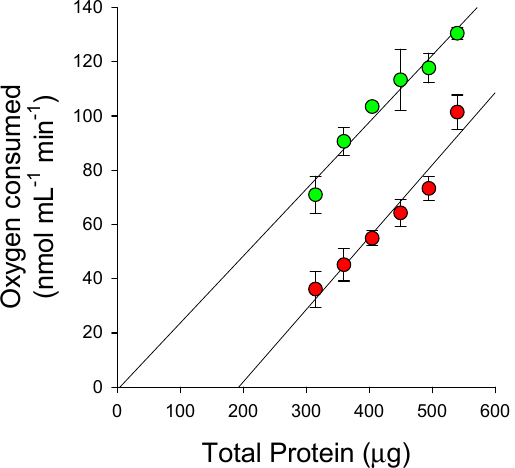
Figure 2. Titration of HPPD activity in TSP extract as measured by oxygen consumption in the presence of 0 ( • ) and 3.75 µ M of 4b ( • ). The reaction mixture contained 0.2 M sodium phosphate (pH 7.2), 1.8 mM ascorbate, 0.2 mM HPP, total soluble protein (0.3–0.5 mg) in a total volume of 3 mL and was incubated at 37 °C. Enzyme and inhibitor were incubated together for 3 min prior to the initiation of the enzymatic reaction by the addition of substrate. Table 1. Structures and activities of 19 2-acyl-cyclohexane-1,3-diones with simple aliphatic side chains tested in this study.